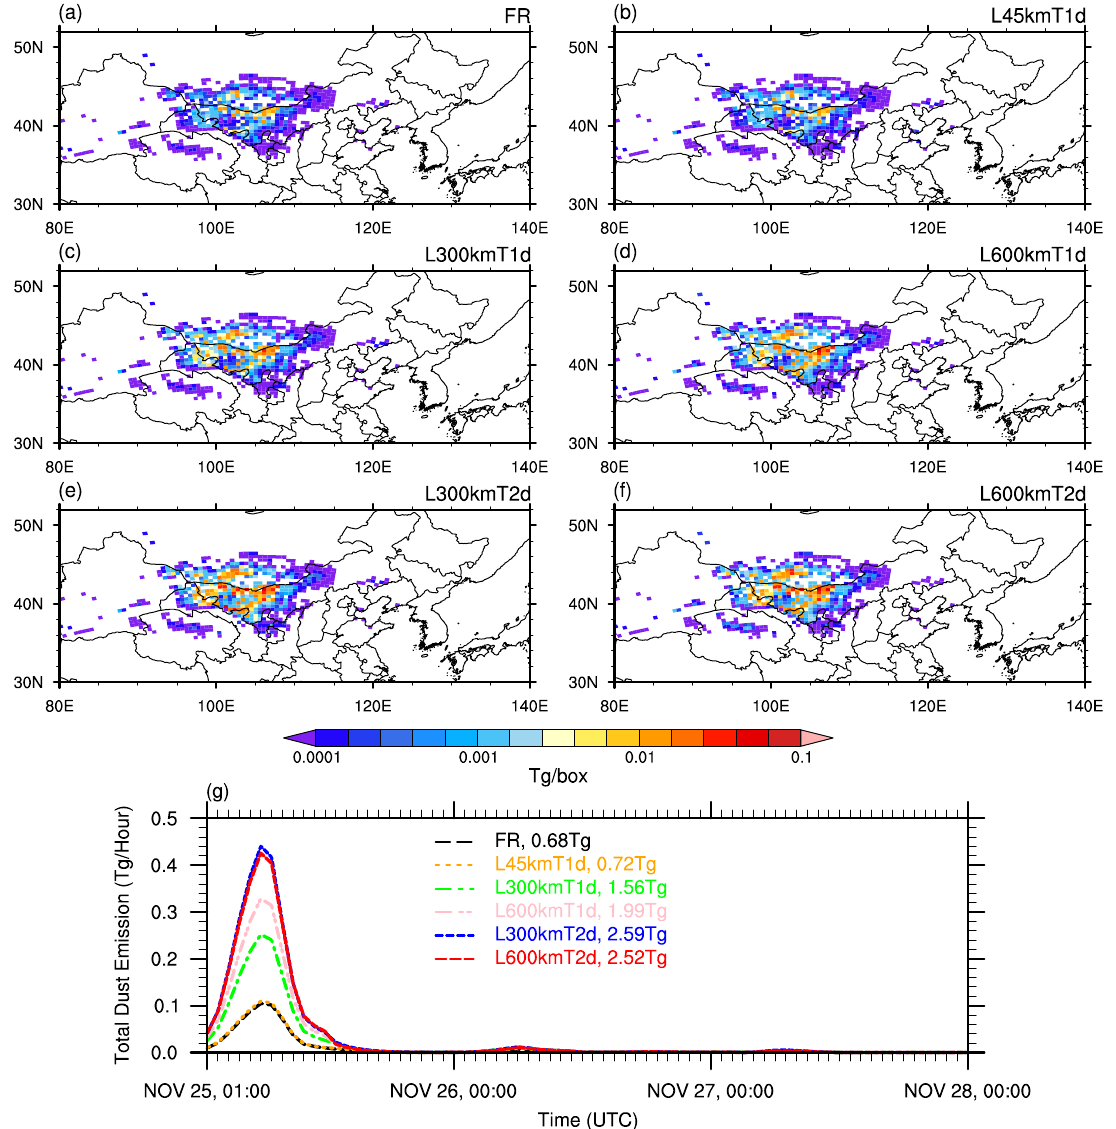
Figure 3. Horizontal distributions of the ( a ) priori and ( b ‒ f ) posterior accumulated dust emissions for the five assimilation experiments during 25–27 November 2016. ( g ) The time series of the hourly total dust emissions over the region 30°N – 52°N and 80°E – 140°E.